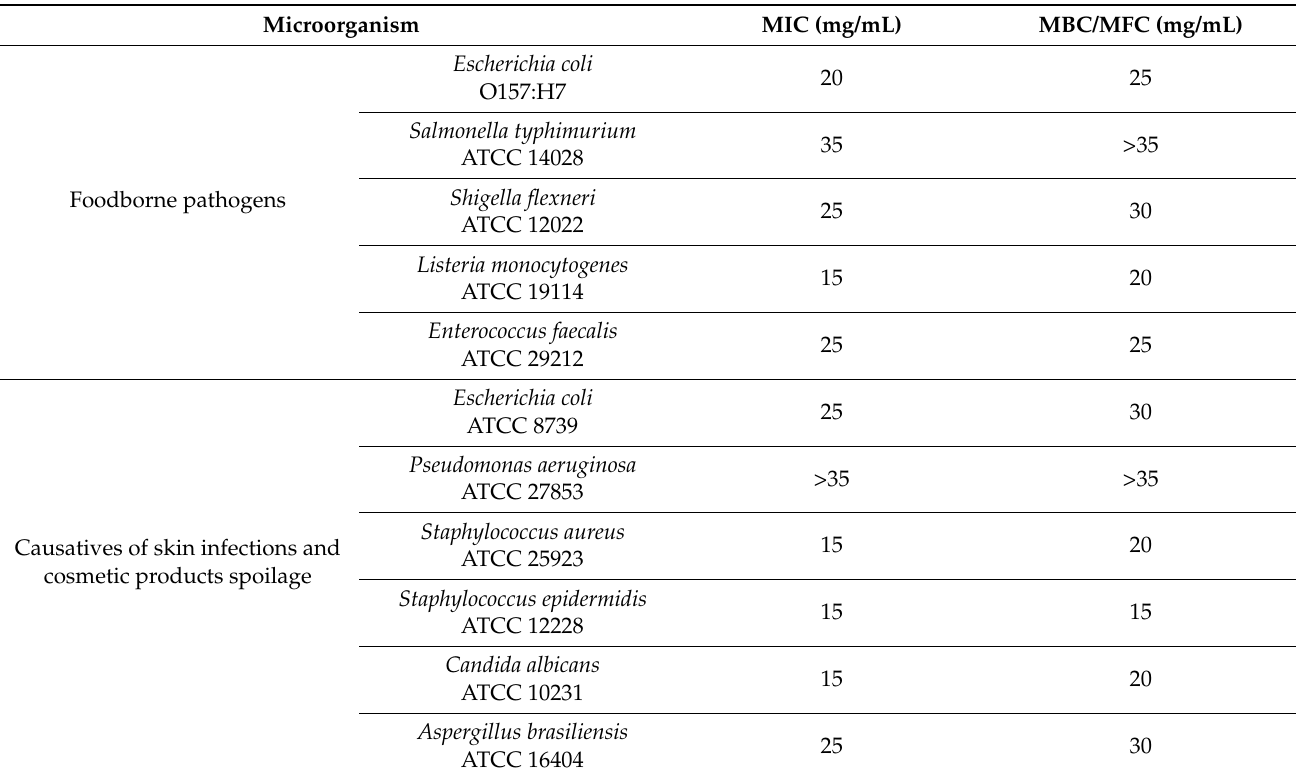
Table 5. Antimicrobial activity of optimized bilberry